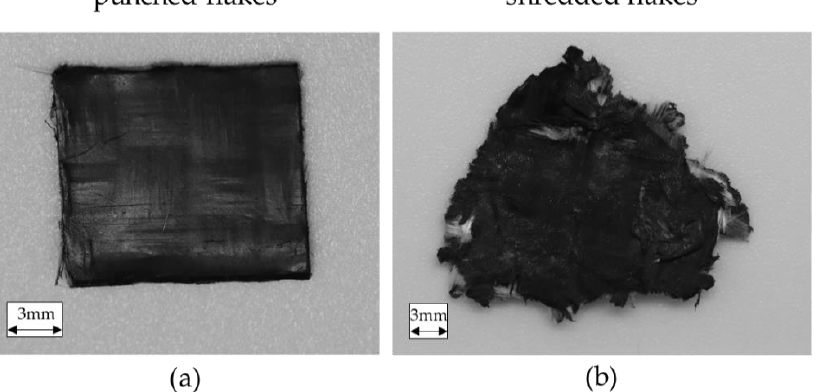
Figure 2. Comparison of the recycling flakes from two crushing processes, ( a ) punched flakes and ( b ) shredded flakes.